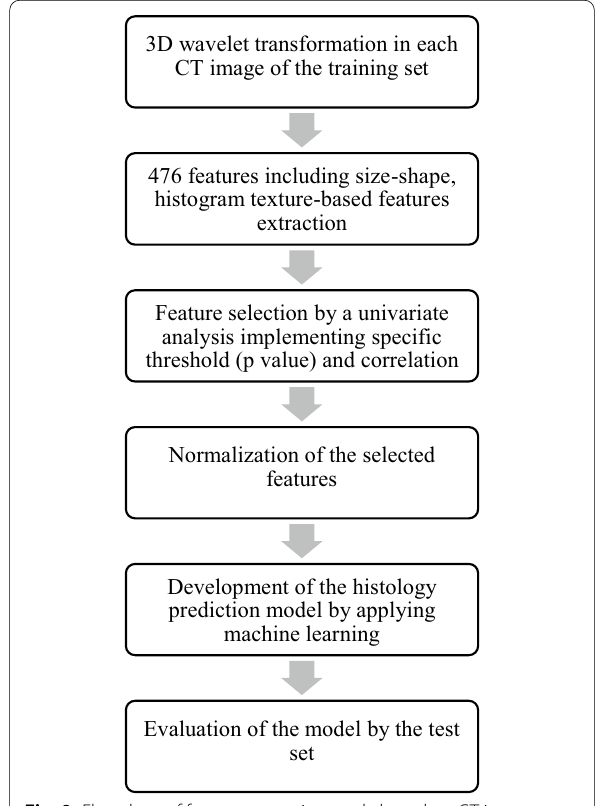
Fig. 9 Flowchart of feature extraction study based on CT images performed by Haga, Akihiro et al.